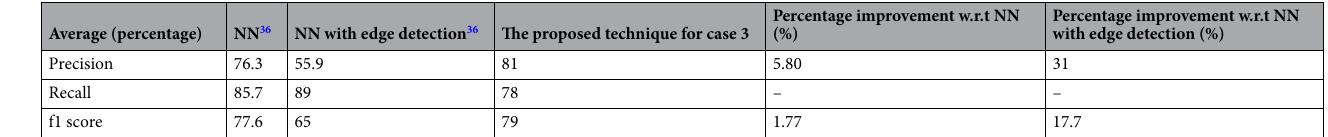
Table 11. Percentage improvement of proposed case 3 w.r.t base